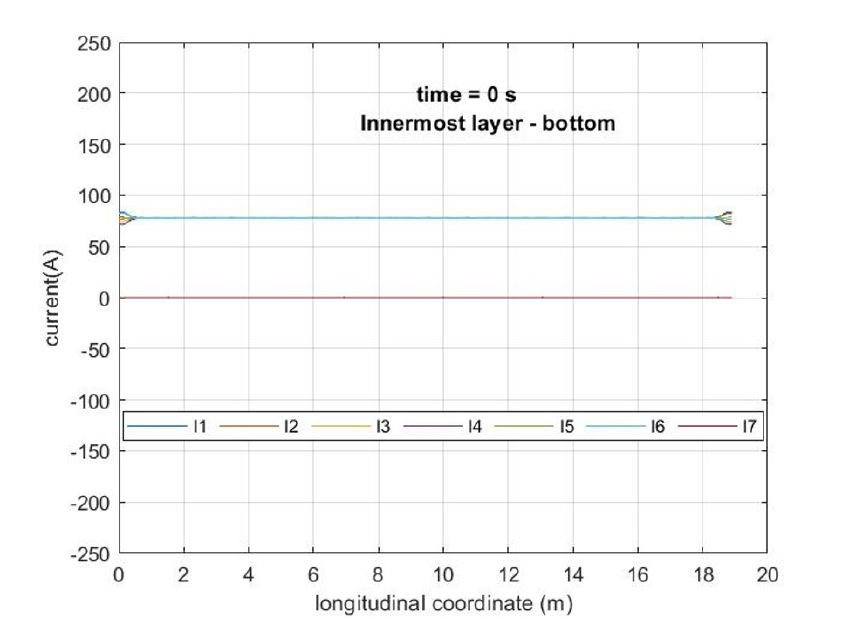
Figure 7. Current of the filaments in ten turns placed at the bottom of the inner layer at t = 0 s (before the discharge starts). The total current of the coil is 467A. Currents denoted from I 1 to I 6 are the currents of the superconductor filaments. Current I 7 is the current of the copper